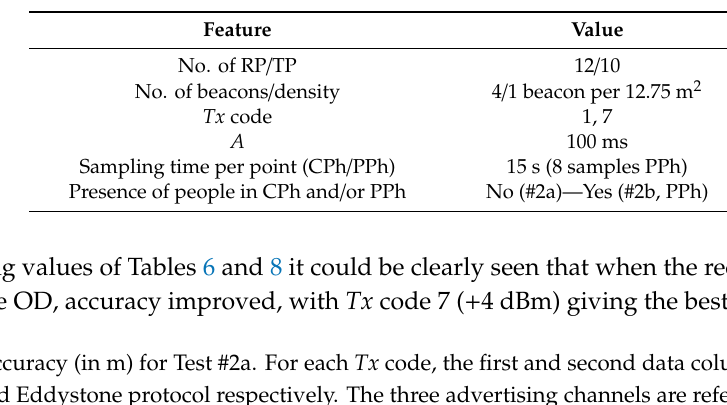
Table 7. Main features of Tests #2a and #2b.